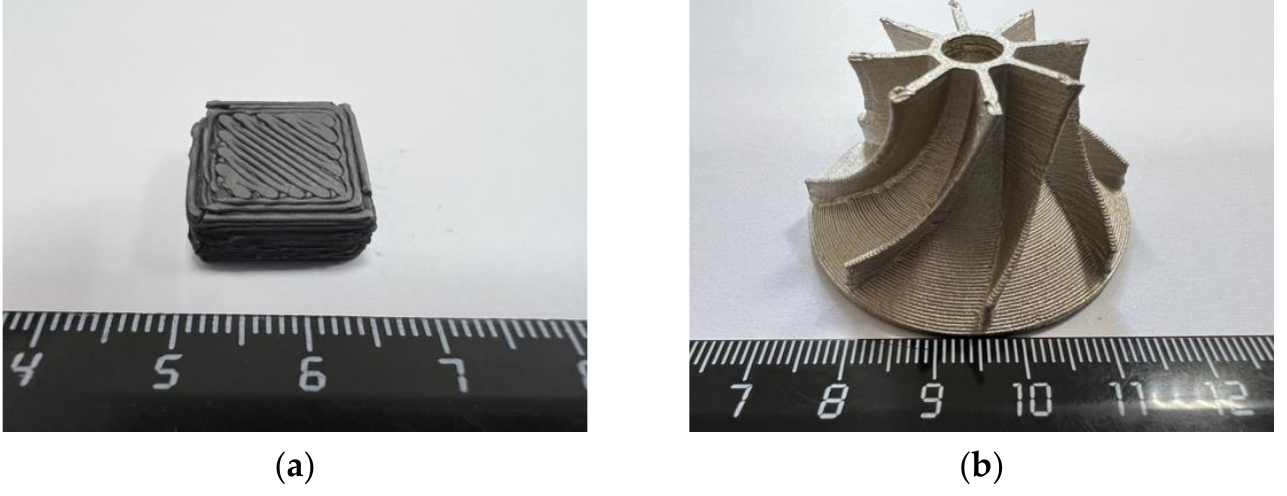
Figure 2. Samples based on nanopowders Ti-Al obtained using additive technologies: ( a ) Experi- mental samples based on Ti-Al intermetallic nanopowders (green detail); ( b ) demonstration sample based on Ti-Al intermetallic nanopowders (after sintering).